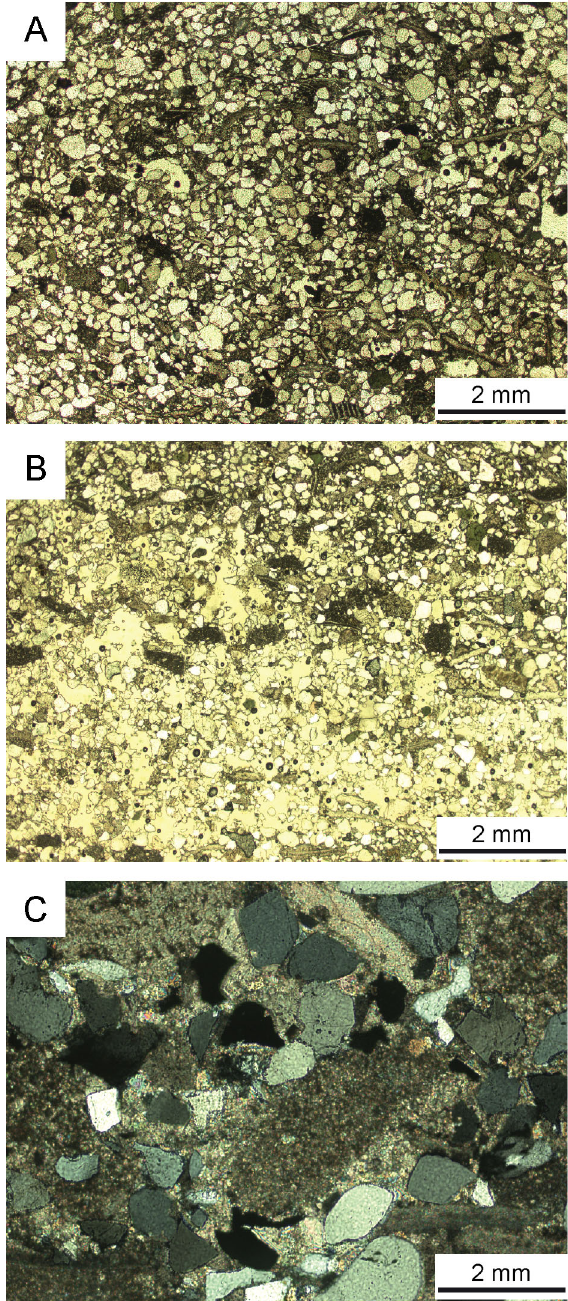
Fig. 6. Thin section photographs of the lowest part of the B unit of the Volkhov Oil Collector in the Vergale-50 core section. A , the sediment is medium-sorted, containing semi- rounded to angular-quartz grains, glauconite, skeletal fragments. B , lamination of finer/denser (upper part of the photo) and coarser quartzitic sediment (lower part of the photo). C , close- up of the thin section (crossed nicols) shows a large mud-roll in the middle of the picture in between the sub-rounded to angular quartz